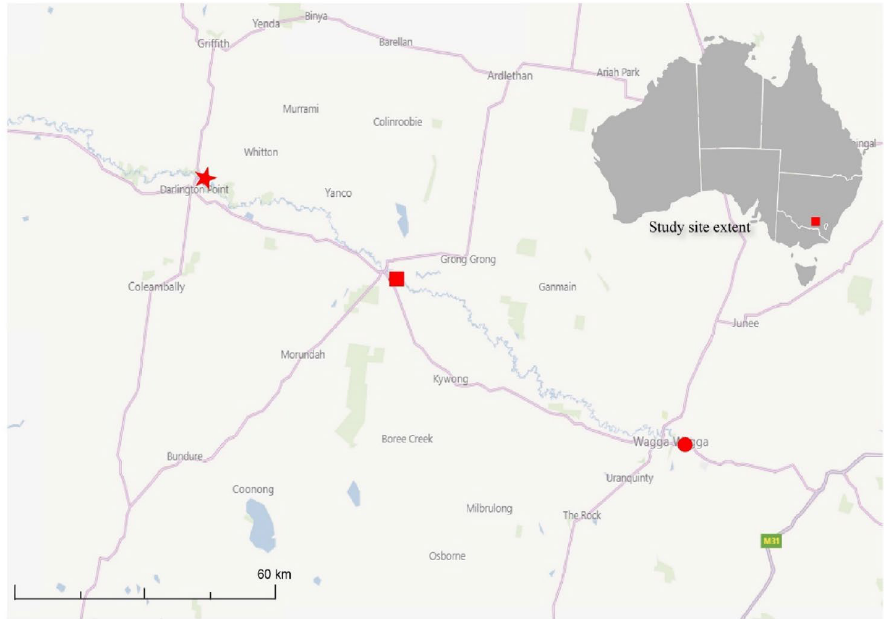
Figure 1. Star represents the Mantangery Lagoon sampling location (34° 35 ′ 30.41 ″ and 146° 4 ′ 12.76 ″ ) in the present study. Map was created by ArcGIS Pro (version 2.8.x -; ESRI (https:// www. esri. com/ en- us/